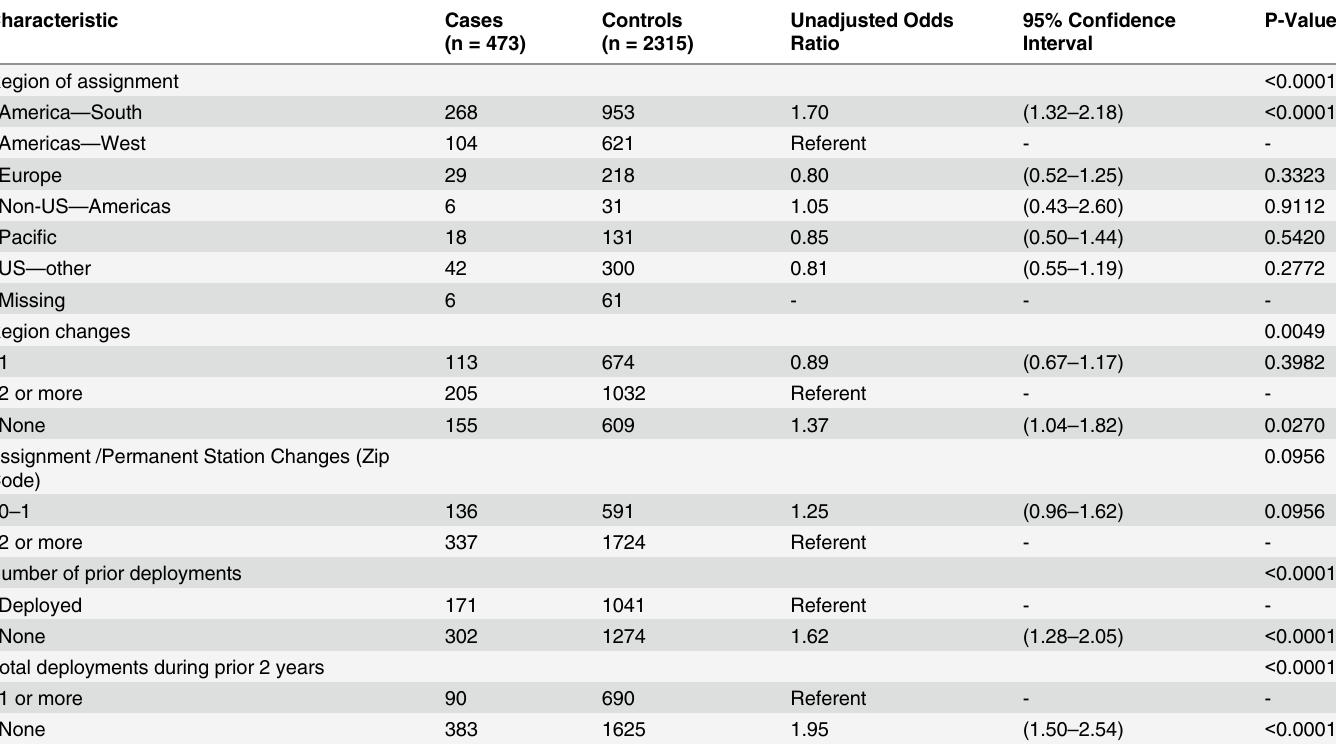
Table 3. Mobility-related factors among HIV-infected and matched HIV-uninfected United States Air Force active duty personnel, 1996 – 2011.